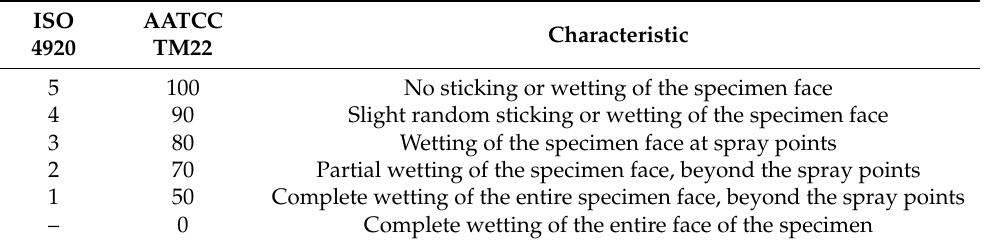
Table 4. Resistance to surface wetting (spray test) rating.